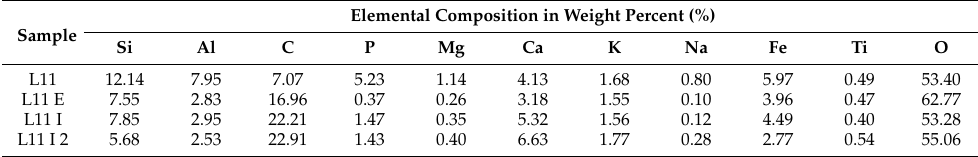
Table 2. Elemental composition of the Monteoru fragment (L11) for ceramic paste and surfaces. Sample